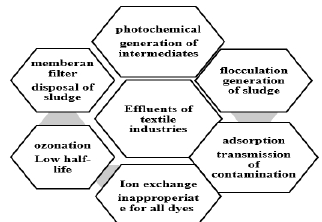
Fig. 1. Advanced treatment methods and their